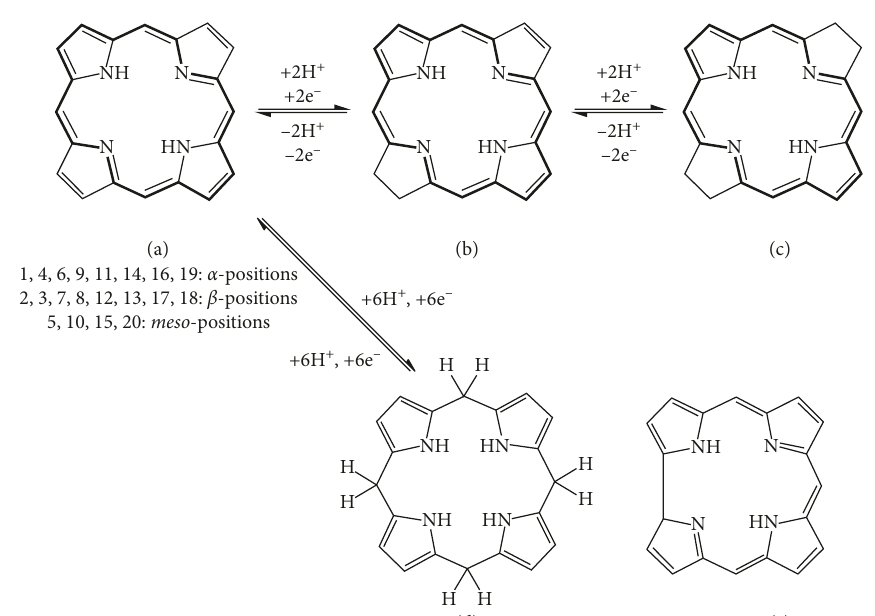
Figure 16: (d) The tetrapyrole derivative porphynogen, a synthetic precursor of the porphyrin ligand. (a) Porphyrin. (b) Chlorin. (c) Bacteriochlorin. (d) Porphyrinogen. (e)